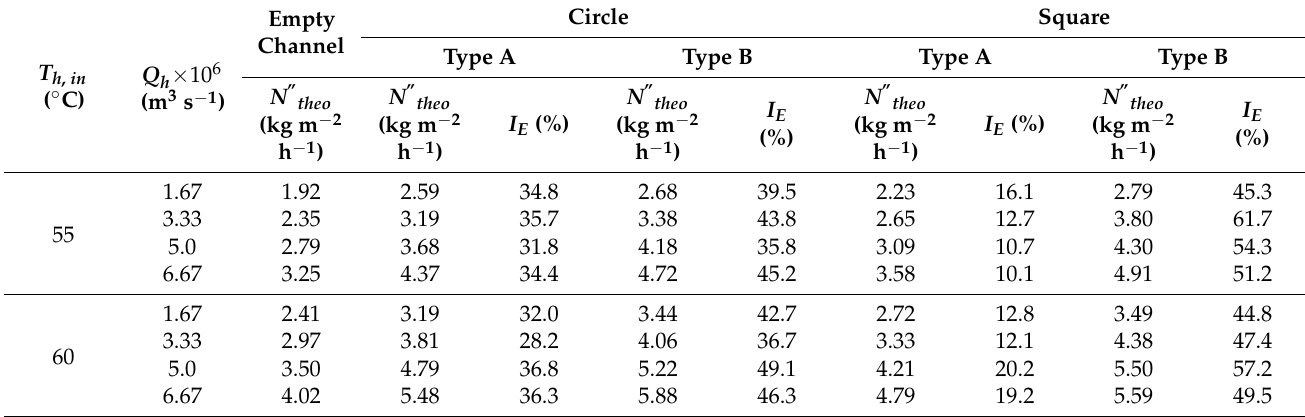
Table 1. Effects of geometric shapes and array patterns on flux enhancement for concurrent flow.